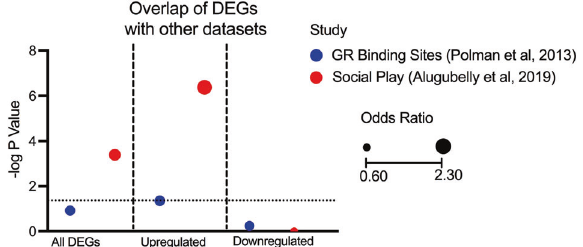
Fig. 4 Enrichment of DEGs between CON vs PPS animals directly following a social test (Direct group) within all existing relevant datasets. Different datasets are plotted on the x axis with − log10 P value on the y axis indicating if there is signi fi cant overlap between each set and DEGs found in this study. Signi fi cant P values appear above the dotted line. The size of the points indicates the odds ratio. DEGs differentially expressed genes, CON control, PPS prepubertal